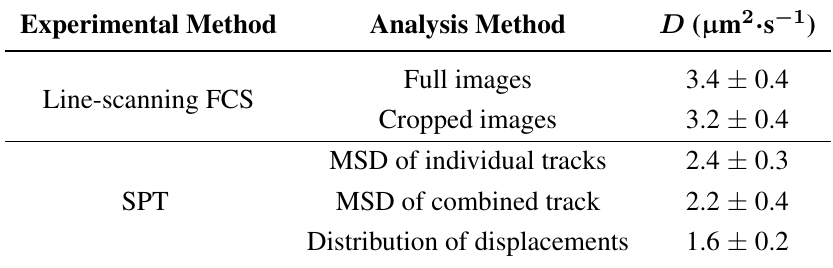
Table 1. Measured diffusion coefficients for DiD in the mitochondria-like membrane. Errors are the standard error of the mean (SEM), except for the value of D extracted from the MSD of the combined track, which was calculated by adjusting the fitting window, as explained in the text, and for that extracted from the distribution of displacements, in which case, the error is the standard deviation of the values obtained for different lag